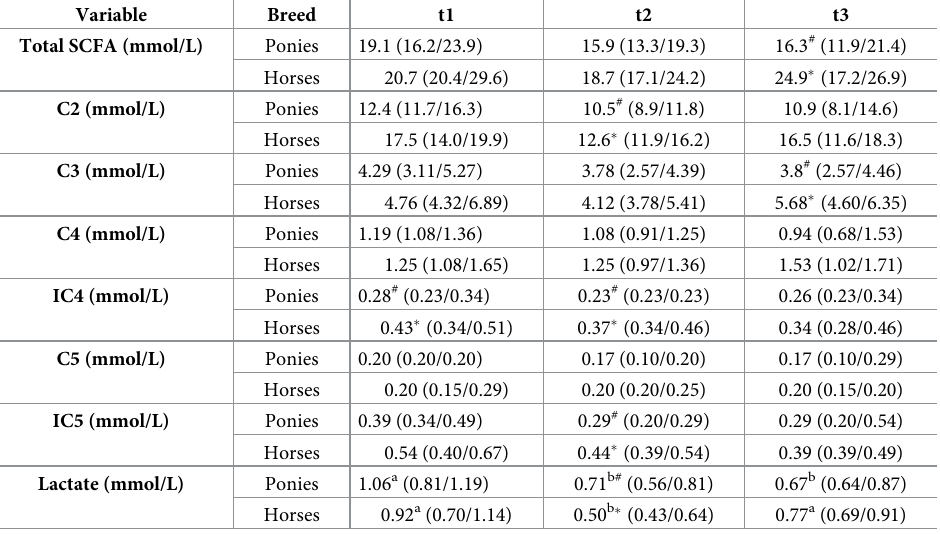
Table 4. Total SCFA, C2, C3, IC4, IC5 and lactate concentrations (mmol/L) in the faeces of horses and ponies. Data are presented as medians and 25/ 75 percentiles in